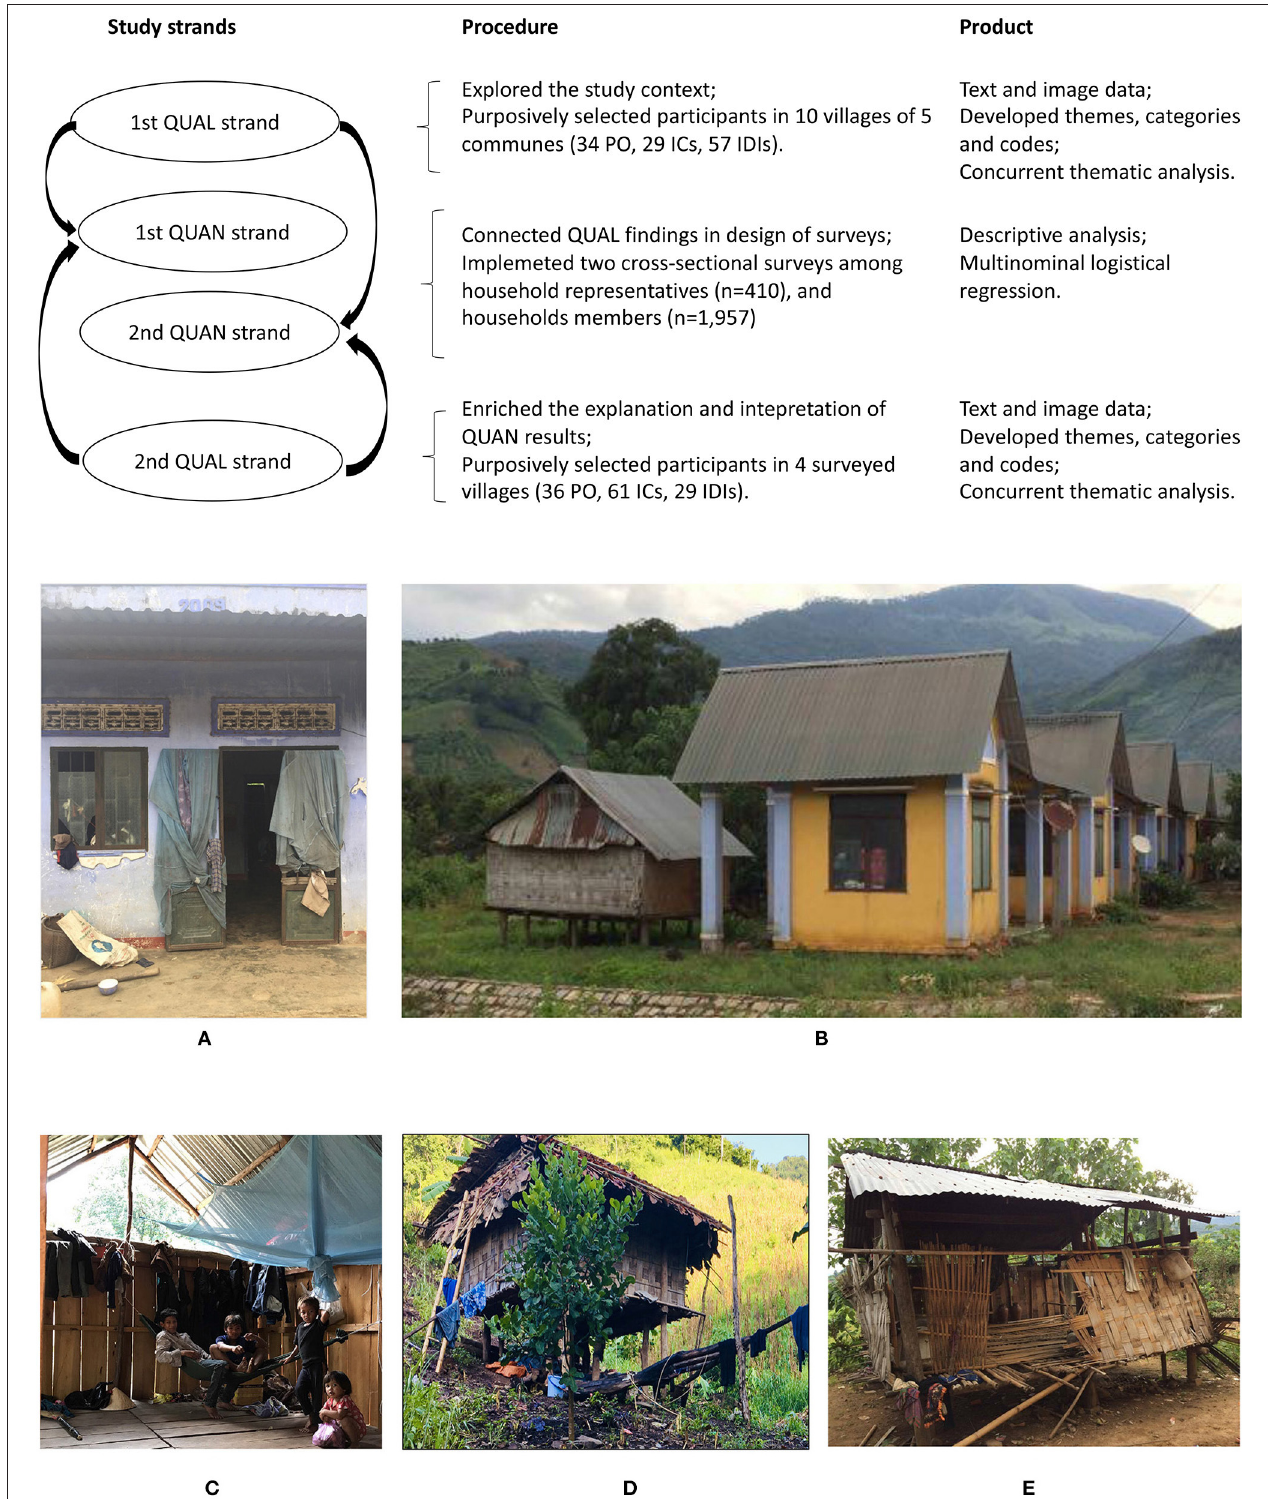
FIGURE 1 | Visual model of the exploratory sequential mixed-methods study design. (A) An abandoned brick house in the new village, (B) Brick houses with additional stilt-houses, (C) Open-eave feature of the stilt house, (D) A Ra-glai traditional stilt house in the traditional territory, and (E) Temporary shelter in the traditional territory.